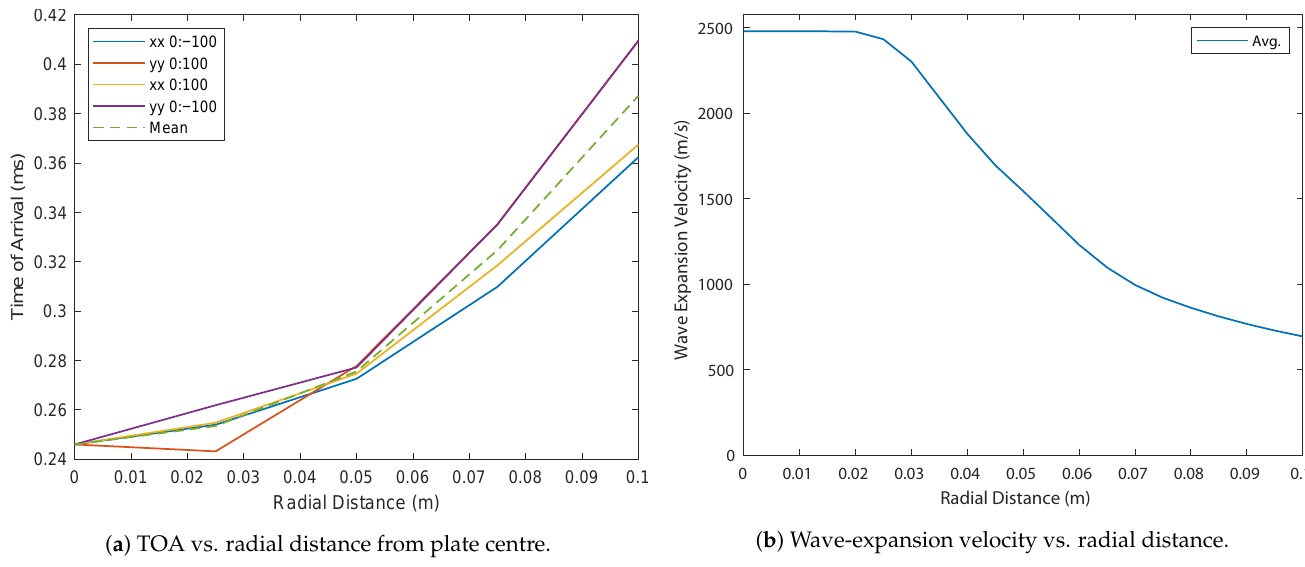
( b ) Wave-expansion velocity vs. radial distance. Figure 9. Time of arrival and wave-expansion velocity for an LB